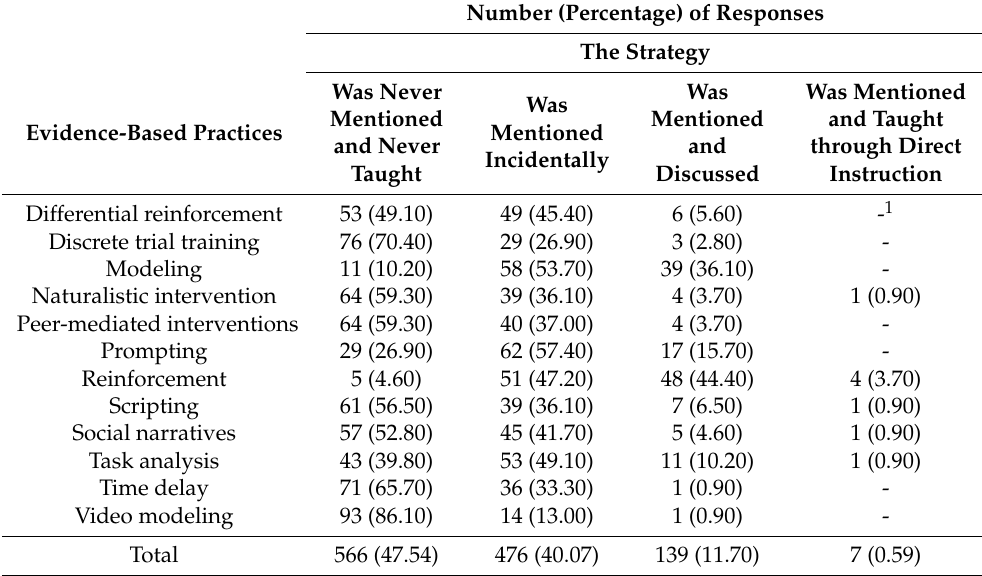
Table 2. Type of Training of Identified Evidence-Based Practices Provides in Teacher Education